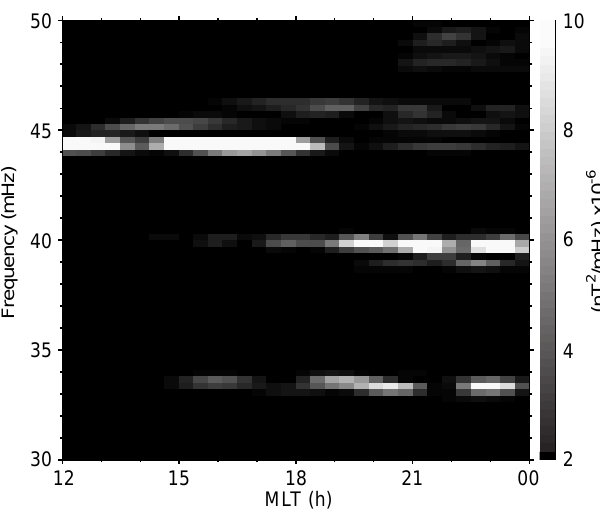
Fig. 8. Fourier-spectrogram of the toroidal magnetic field compo- nent b (cid:47) versus magnetic local time at the position of the s/c at L (cid:136) 6 : 8 and 9 (cid:14)